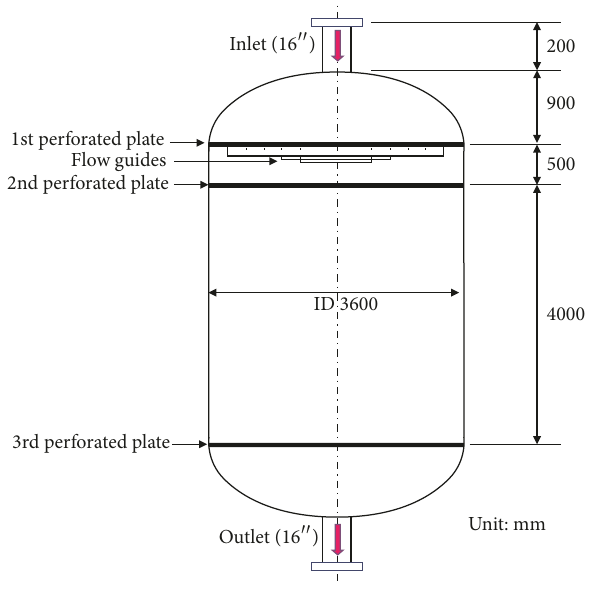
Figure 1: Previous decay tank model [1, 2].